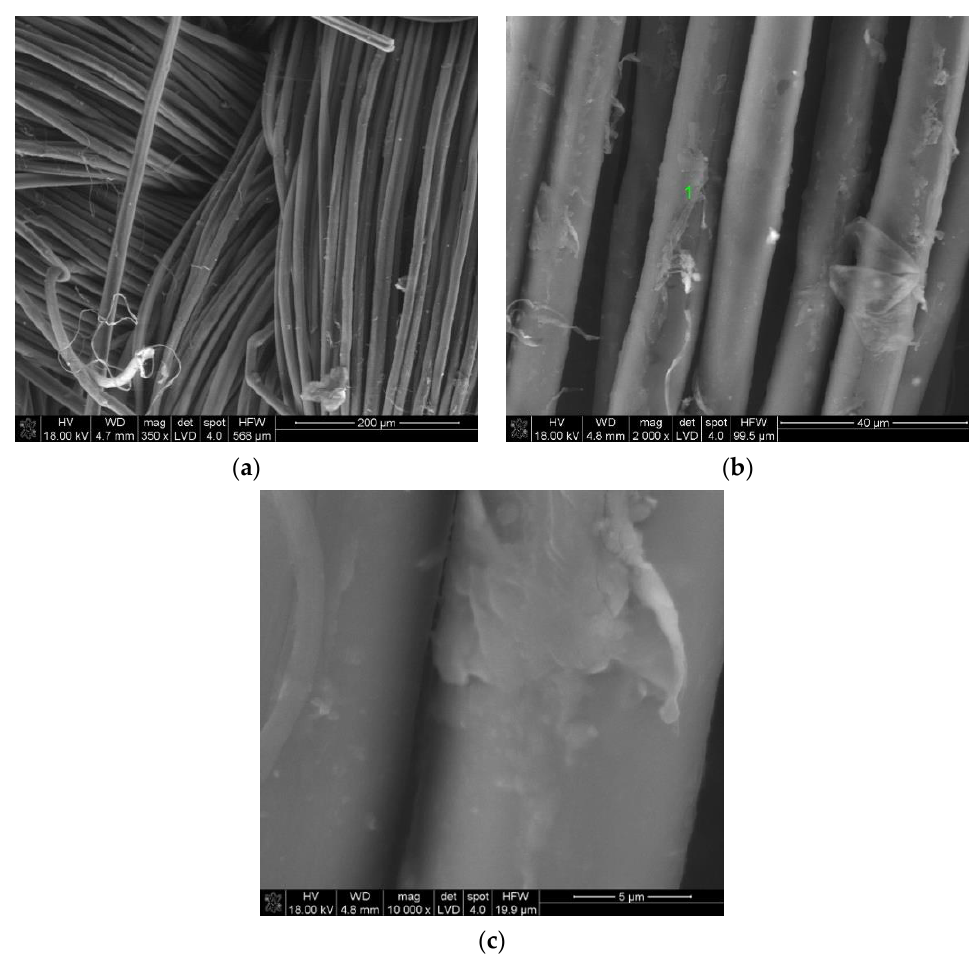
Figure 10. SEM image of Ti-Si coated PROTON fabric at magnification of ( a ) 350×; ( b ) 2000×; ( c ) 10,000×; point “1” is marked for EDS analysis.